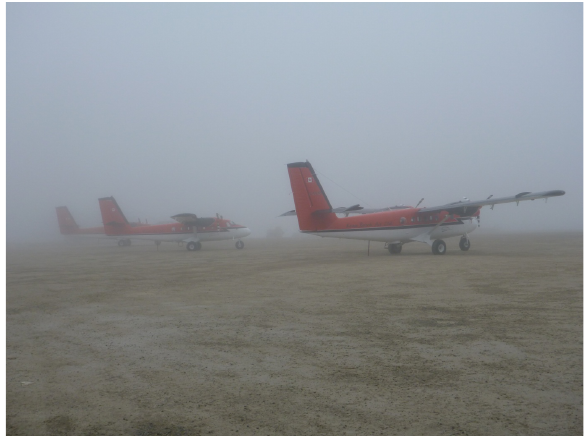
Figure 3. Perfect weather for fog minkes (Photo: D. G. Pike). WHY BIOLOGISTS COUNT ANIMALS